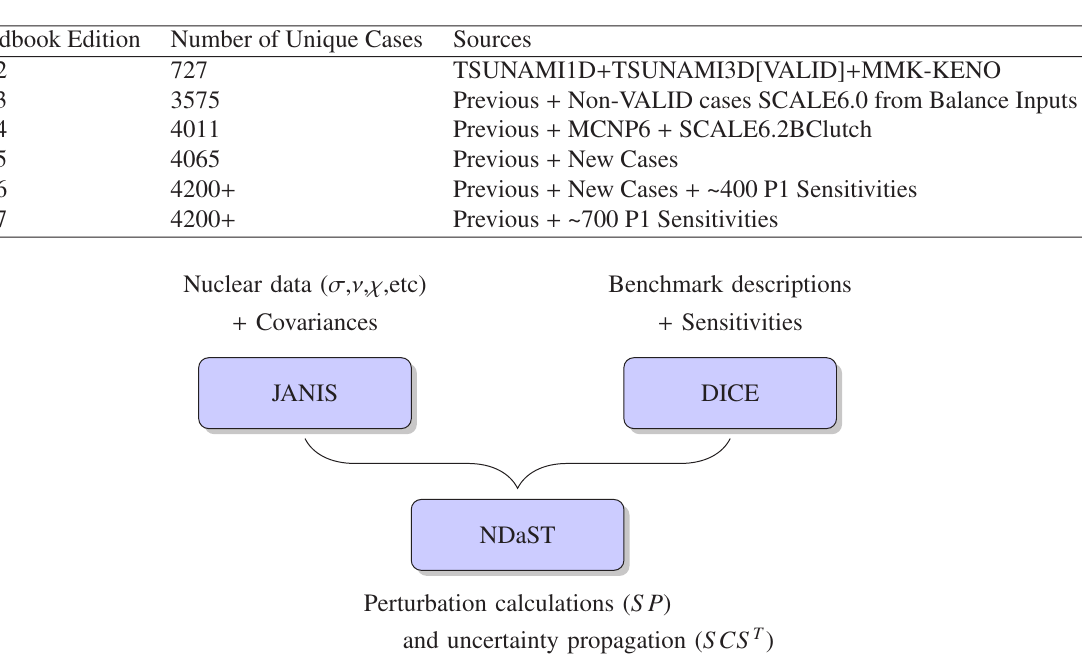
Table 1. History of the ICSBEP Handbooks and the inclusion of sensitivity profile data with data sources identified.